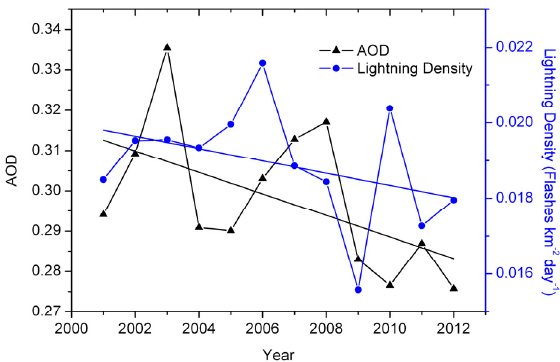
Figure 2 . Variation of regional annual mean AOD and lightning flash density (flashes km − 2 ·year − 1 ) over China from 2001 to 2012.